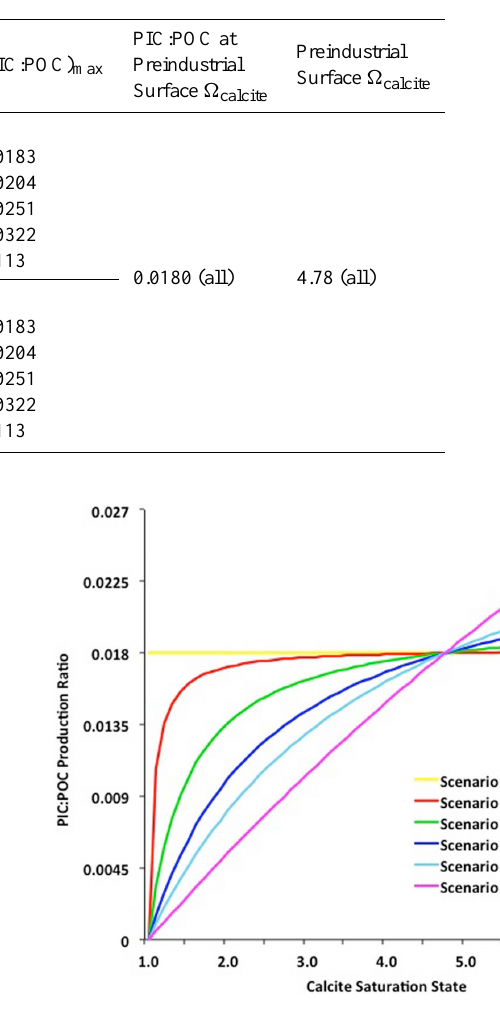
Table 1. Summary of model run calibrations.